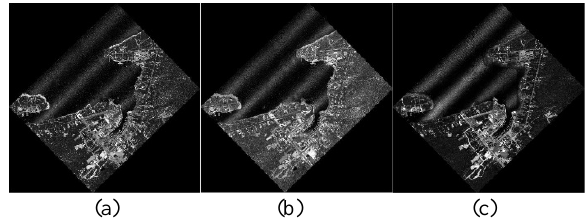
Figure 5. Multispectral ALS height models on the study area: (a) H First+Max ; (b) H First+Avg ; and (c) H All+Min . n.d.). Based on the average point spacing of the dataset (Channel 1: 0.45 m per point; Channel 2: 0.43 m per point; Channel 3: 0.44